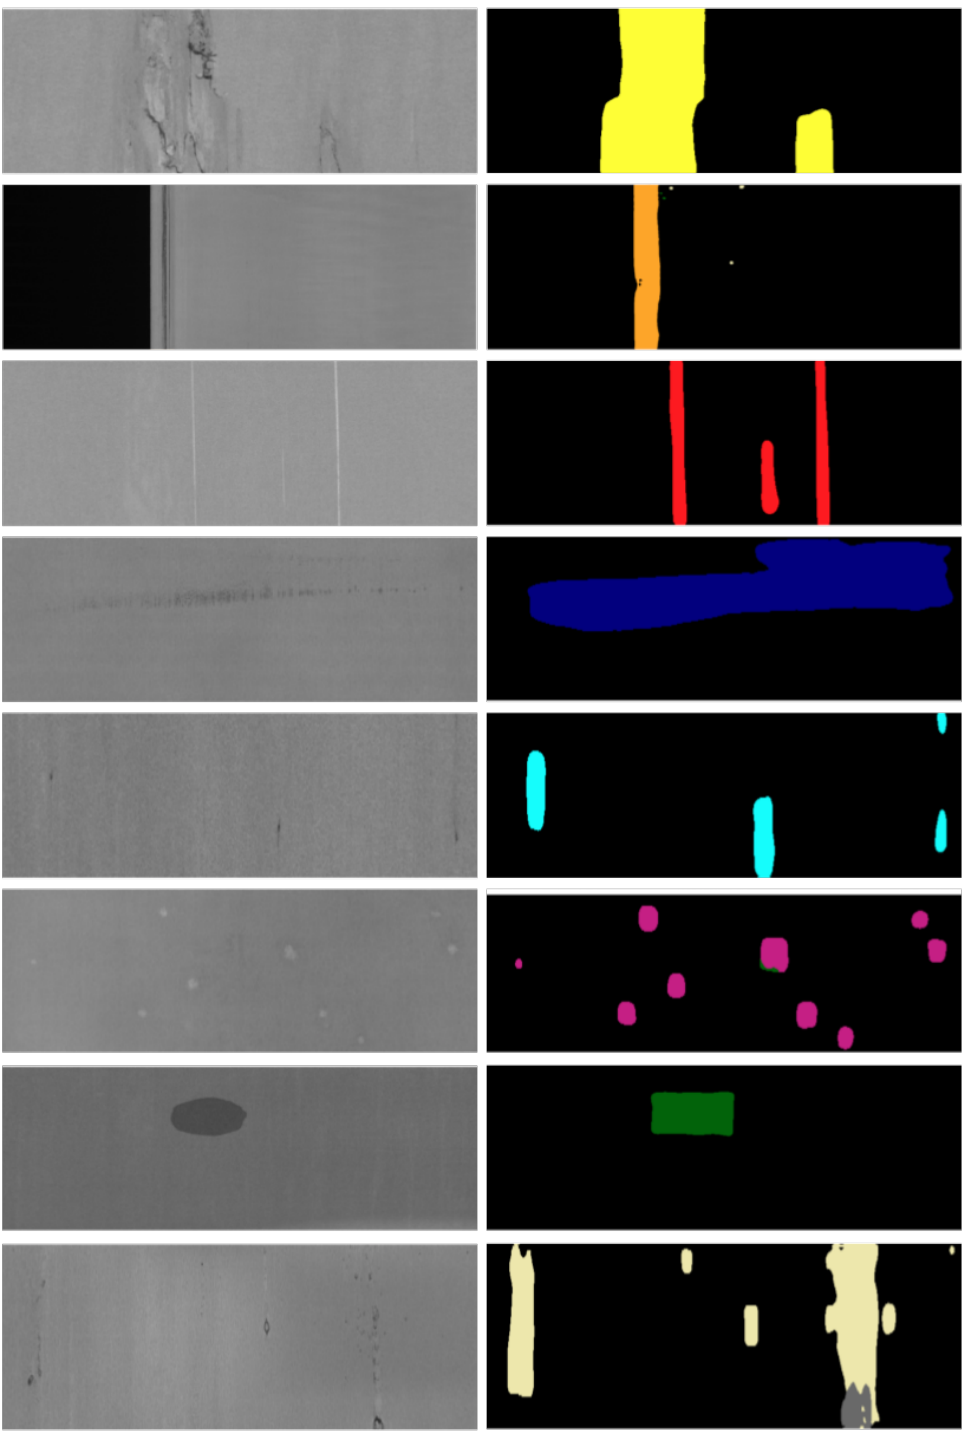
Figure 10. Example predictions of the defect type segmentation model (validation data). It is clearly visible that, although a large portion of the dataset includes rectangular target masks, the segmentation of the defects has a more confined border. However, sometimes, the segmentation can have a rectangular shape as in the example image in the second last row. Nevertheless, it is clear that the model is capable of segmenting most defects while also predicting the right